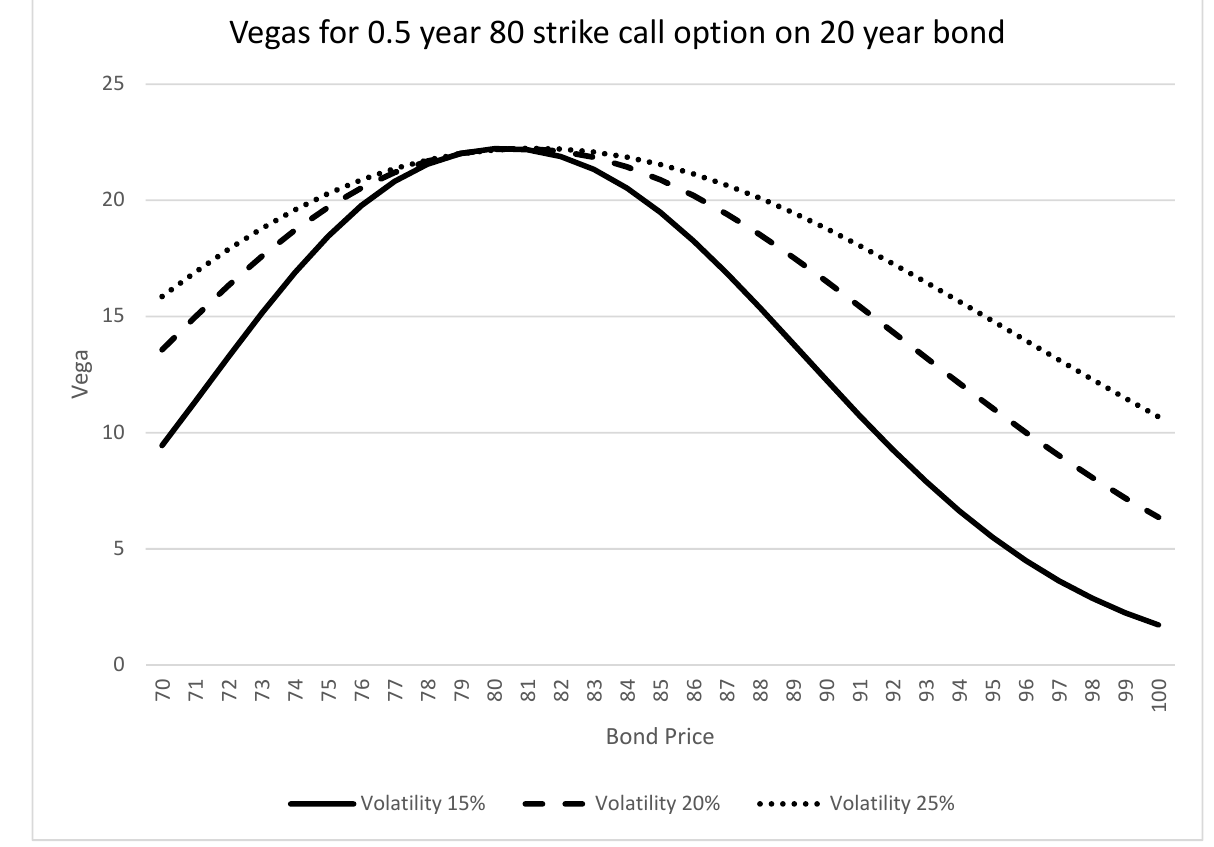
Figure 8. PTP vegas at different volatilities.